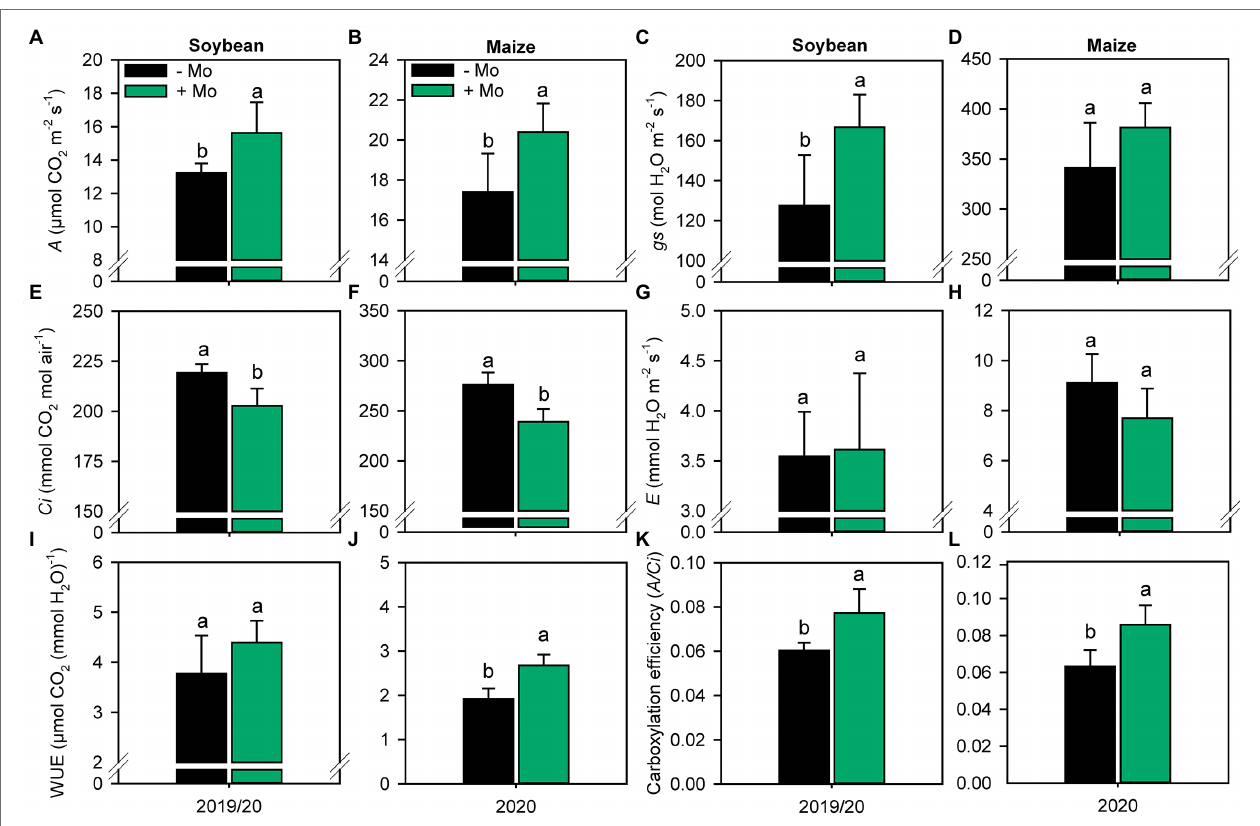
FIGURE 4 | Net photosynthetic rate, A (A,B) ; stomatal conductance, gs (C,D) ; substomatal CO 2 concentration, Ci (E,F) ; leaf transpiration, E (G,H) ; water use efficiency, WUE (I,J) ; and carboxylation efficiency, A/Ci (K,L) of soybean and maize plants as affected by foliar Mo fertilization. Different lowercase letters represent statistical difference between treatments (presence or absence of Mo) according to the F test ( p ≤